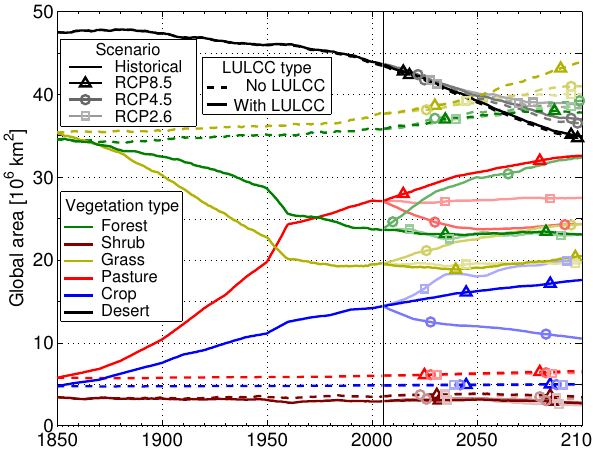
Figure 1. Evolution of the global area of different vegetation and surface types resulting from gross and no LULCC combined with dynamic vegetation. Different experiments have different line styles, different surface types have different colour and different scenarios have different brightness (same brightness for historical and RCP8.5, since they do not have any temporal overlap). Desert: area without vegetation under current climate. Glacier and bare rock area which can never have vegetation is constant about 16 × 10 6 km 2 throughout the experiments. Minor differences between net and gross LULCC are discussed in the text.